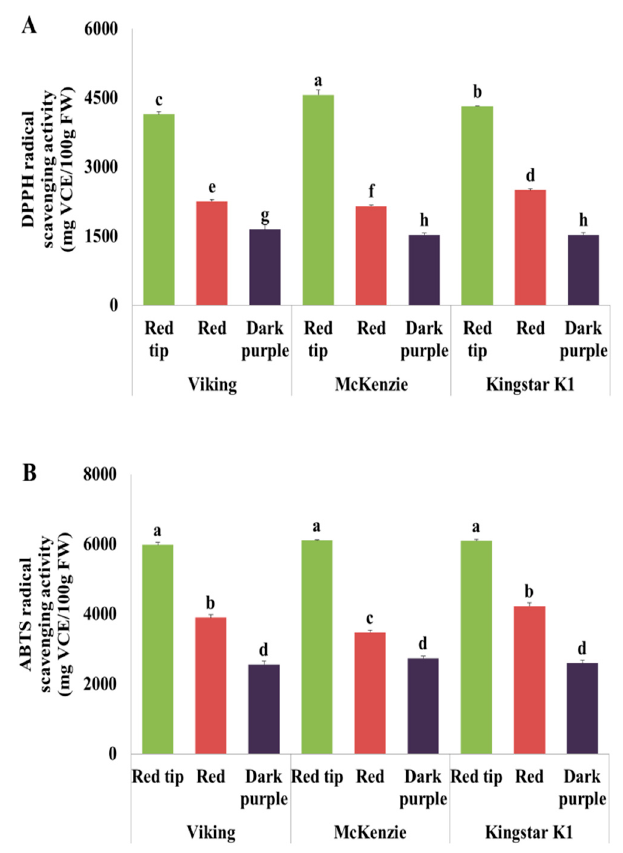
Figure3. Antioxidantactivitiesof Aroniamelanocarpa fruitsatdi ff erentmaturitystages: ( A )DPPHradical scavenging; ( B ) ABTS radical scavenging. Vertical bars indicate standard deviation. Di ff erent letters are significant di ff erences by Duncan’s multiple range test ( p <